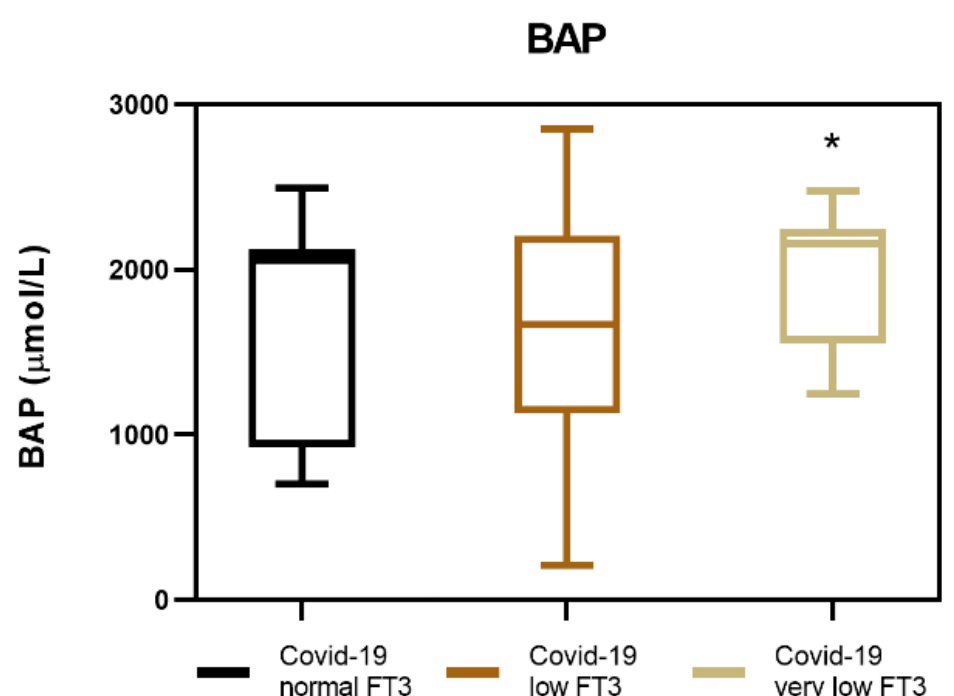
Figure 2. Measurement of biological antioxidant potential (BAP) in COVID-19 patients with NTIS. * p < 0.05.